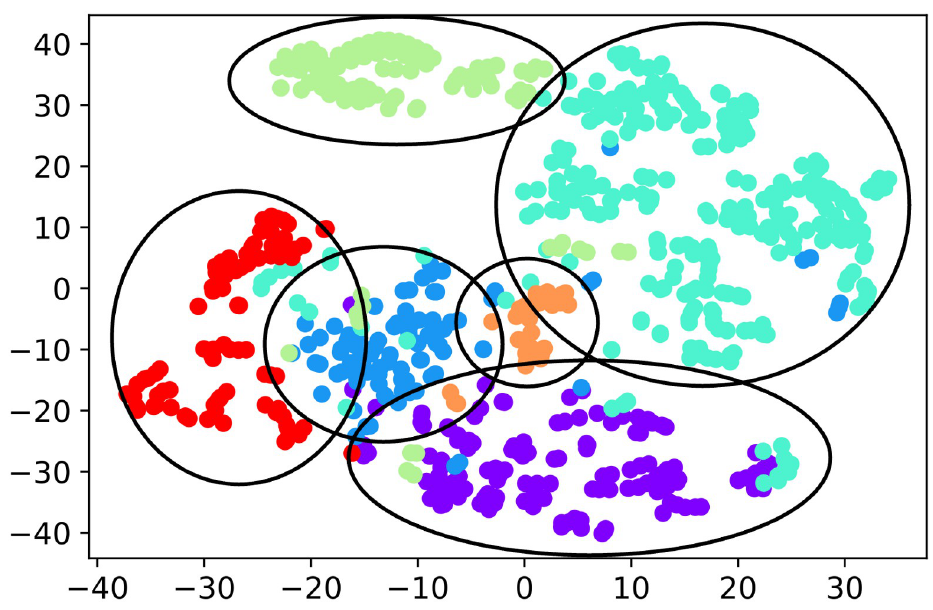
Fig 11. Visualization of CMD super features. We cluster n-gram sequences based on a variant of Jaccard similarity.